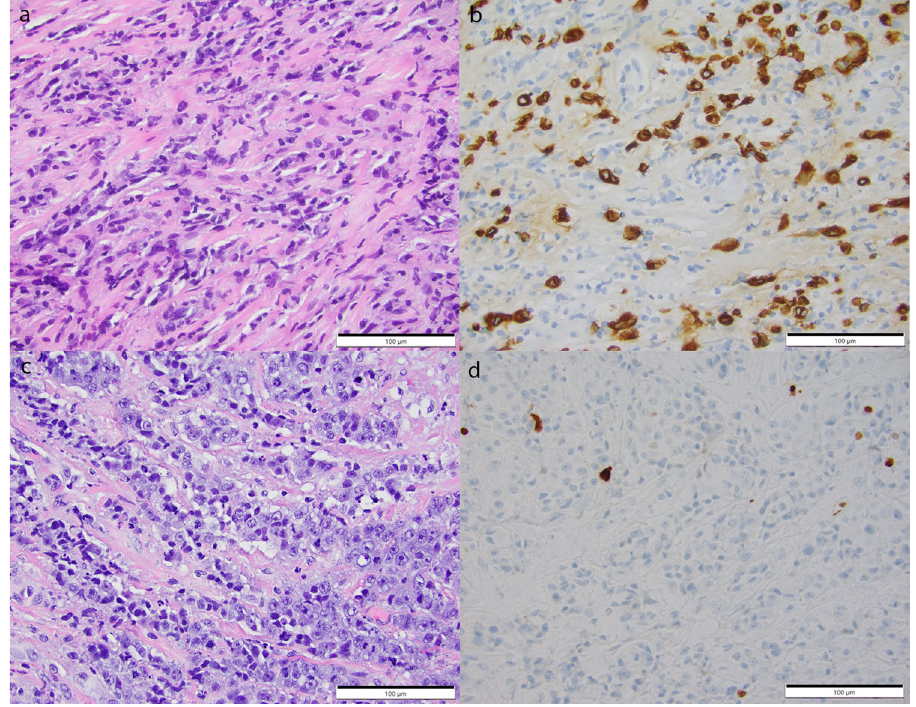
Fig. 3 Cases from two patients who responded completely to neoadjuvant chemotherapy. First case with high stromal tumor-in fi ltrating lymphocytes as seen on pre-therapy core biopsy ( a H&E, b Cytokeratin AE1/AE3 highlighting the cancer cells with background unstained lymphoid cells). Second case with low Ki-67 proliferation index but high mitotic activity ( c H&E, d Ki-67 immunohistochemical stain). Scale bar = 100